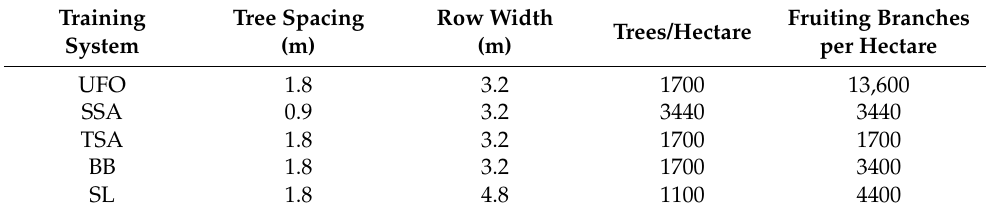
Table 1. Details of the different training systems for ‘Kordia’ sweet cherry trees utilised in the